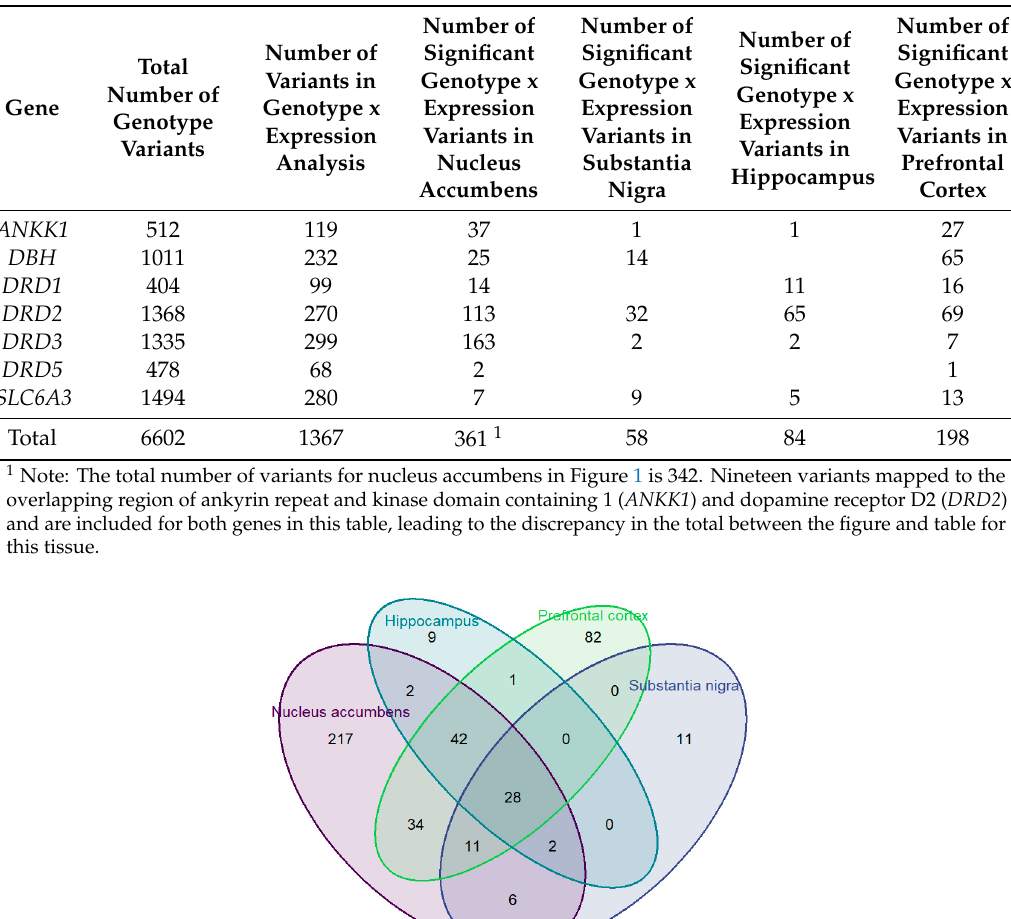
Table 1. Genotype x expression variants by tissue.